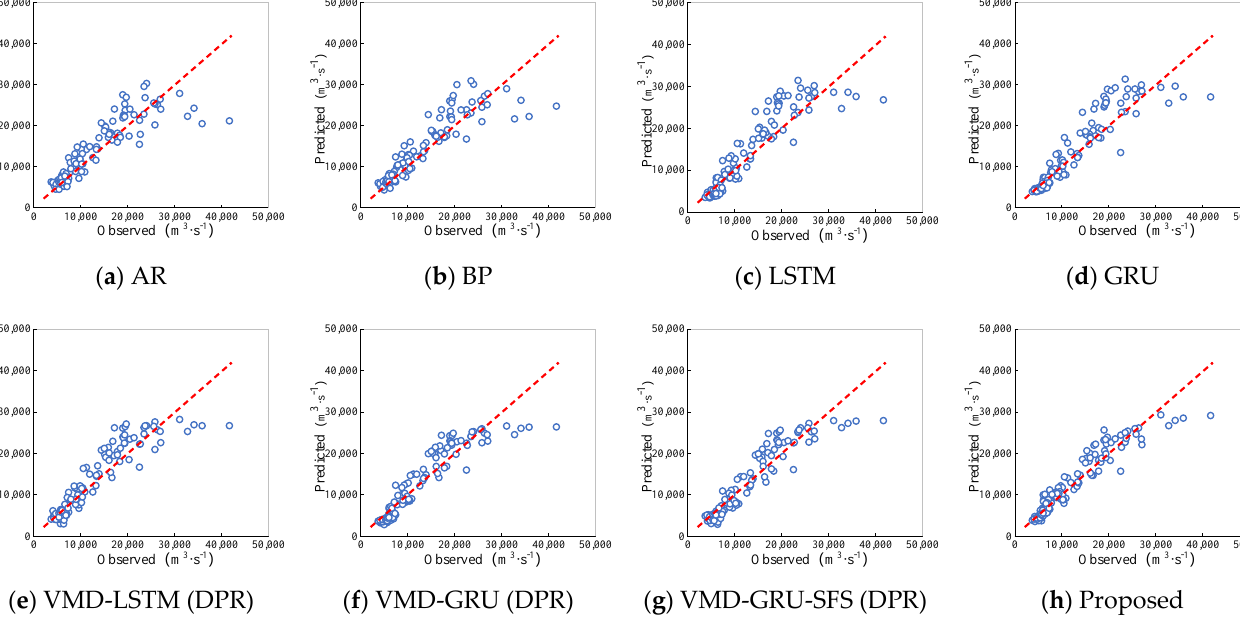
Figure 8. Scatter plots of different methods for the Yichang station. ( a ) AR model; ( b ) BP model; ( c ) LSTM model; ( d ) GRU model; ( e ) VMD-LSTM (DPR) model; ( f ) VMD-GRU (DPR) model; ( g ) VMD-GRU-SFS (DPR) model; ( h ) Proposed model. It can be clearly seen from the scatter diagram of Figures 7 and 8 that the prediction performance of various models is obviously different. The scattered points of AR and BP